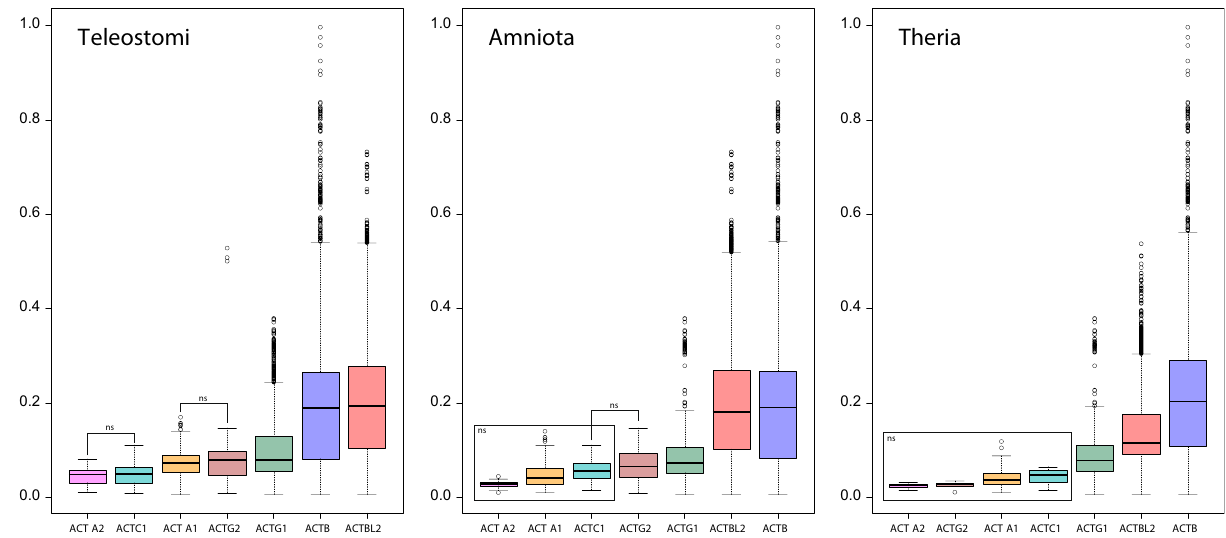
Figure 2. Box-plots of phylogenetic distances measured by the number of amino acid substitutions per site (y-axis) for seven actin groups (x-axis). Teleostomi includes bony fishes and tetrapods, Amniota contains reptiles, birds, and mammals, and Theria comprises marsupials and placentals. The thick line indicates the median. The colored box shows the quartile range, and the whiskers denote the range without outliers. All pairwise comparisons except those noted by ns (non-significant) are statistically significant with p <